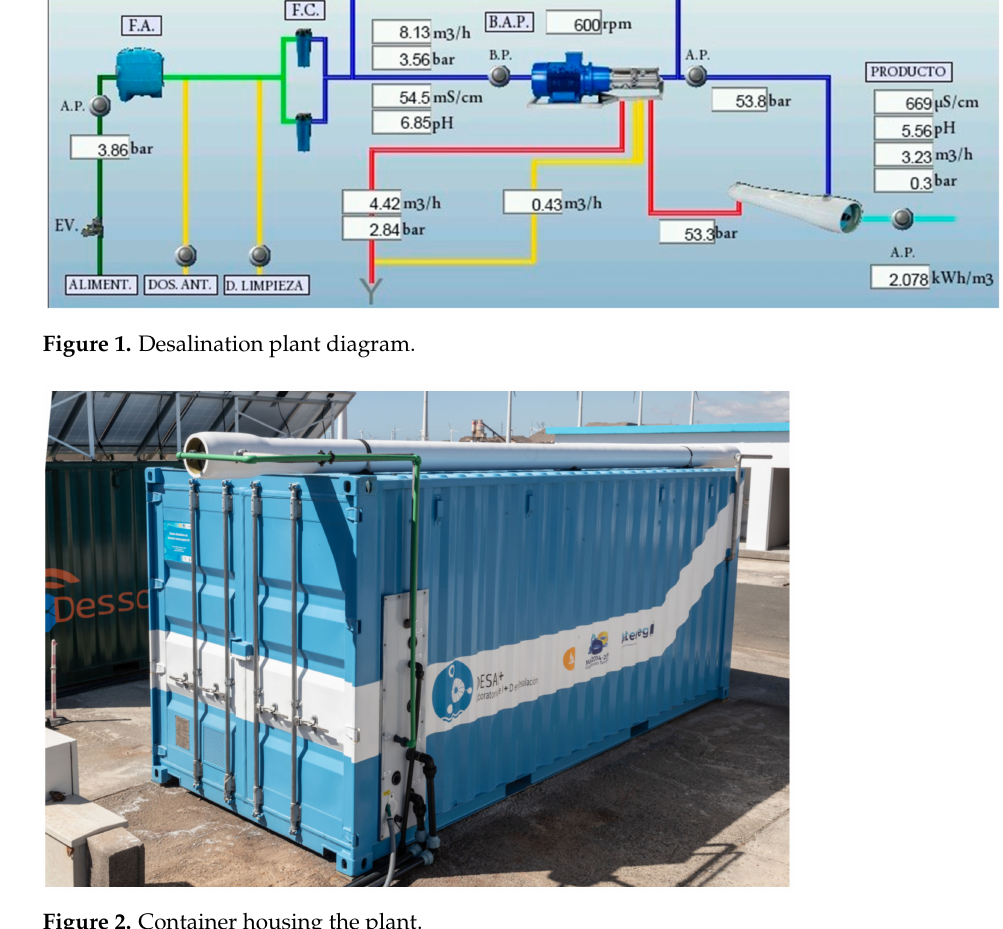
Figure 2. Container housing the plant. Table 1. Main parameters of the SWRO plant used in the